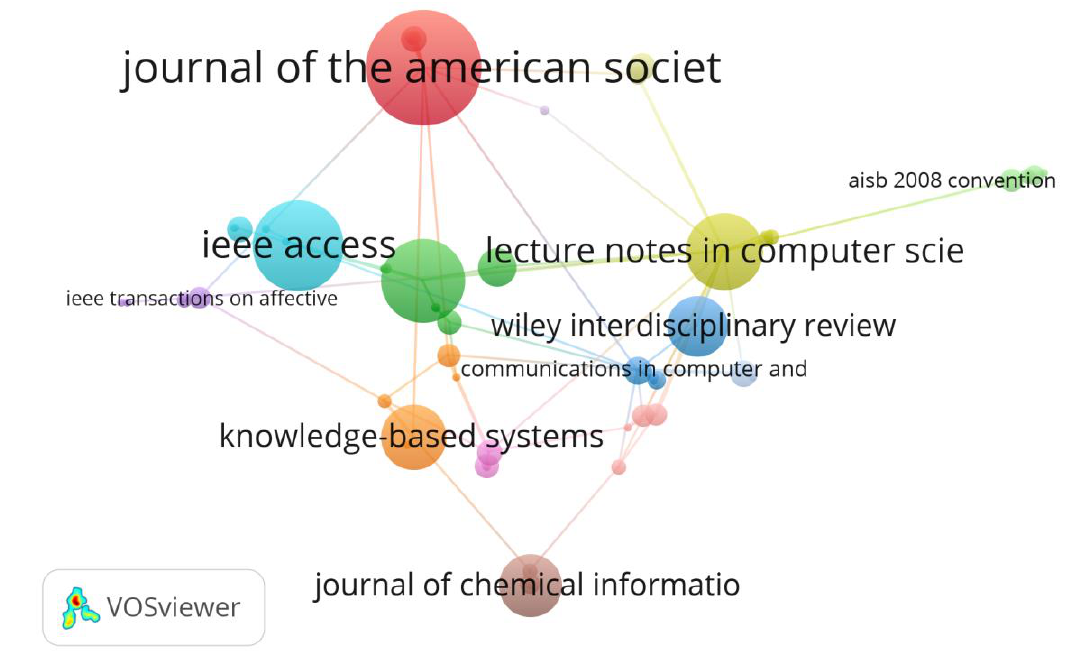
Figure 20. Highest cited sources using a network graph. Table 20. Highly cited sources, links, citations, and publication